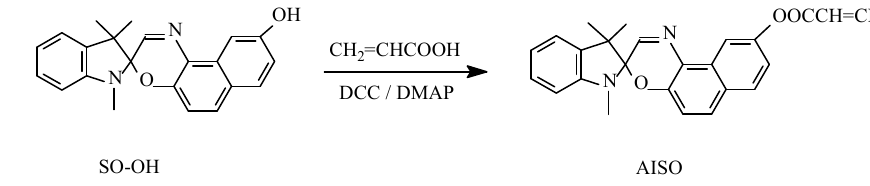
Figure 1. Synthetic route to obtain monomer AISO.